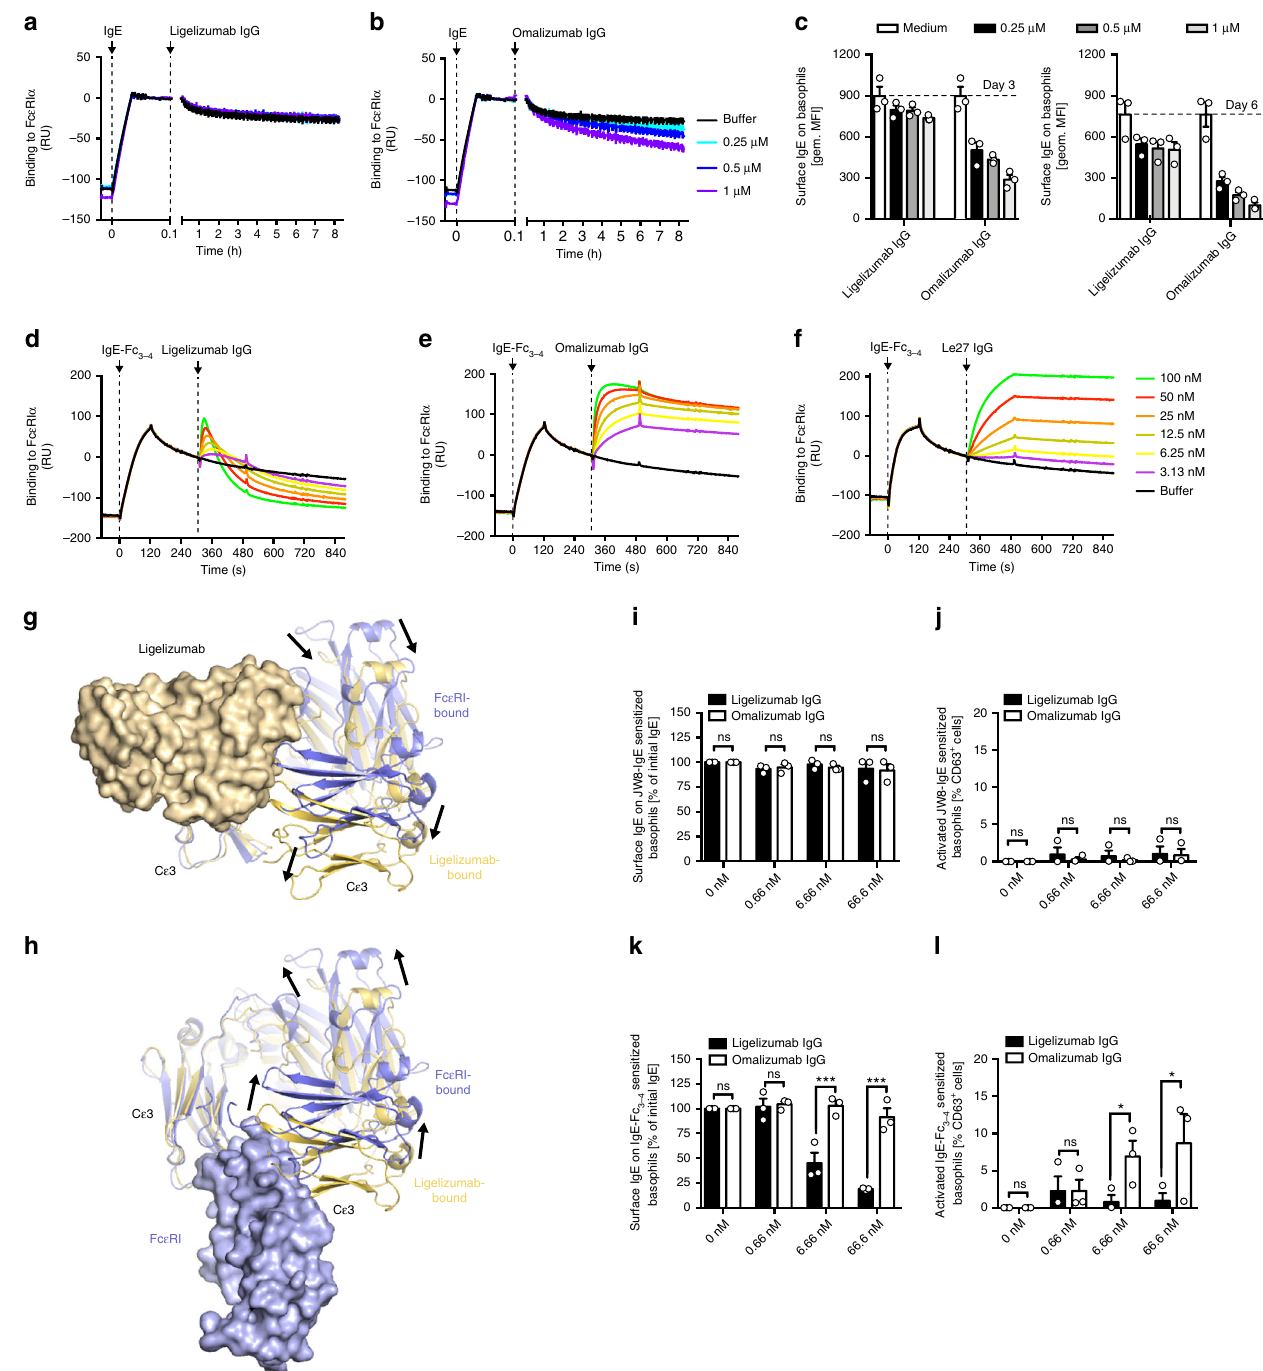
RPMI8866 surface is dependent on the presence of CD23:IgE complexes. By adding 12.5 nM JW8-IgE and an equimolar amount of ligelizumab to RPMI8866 cells, roughly one-third